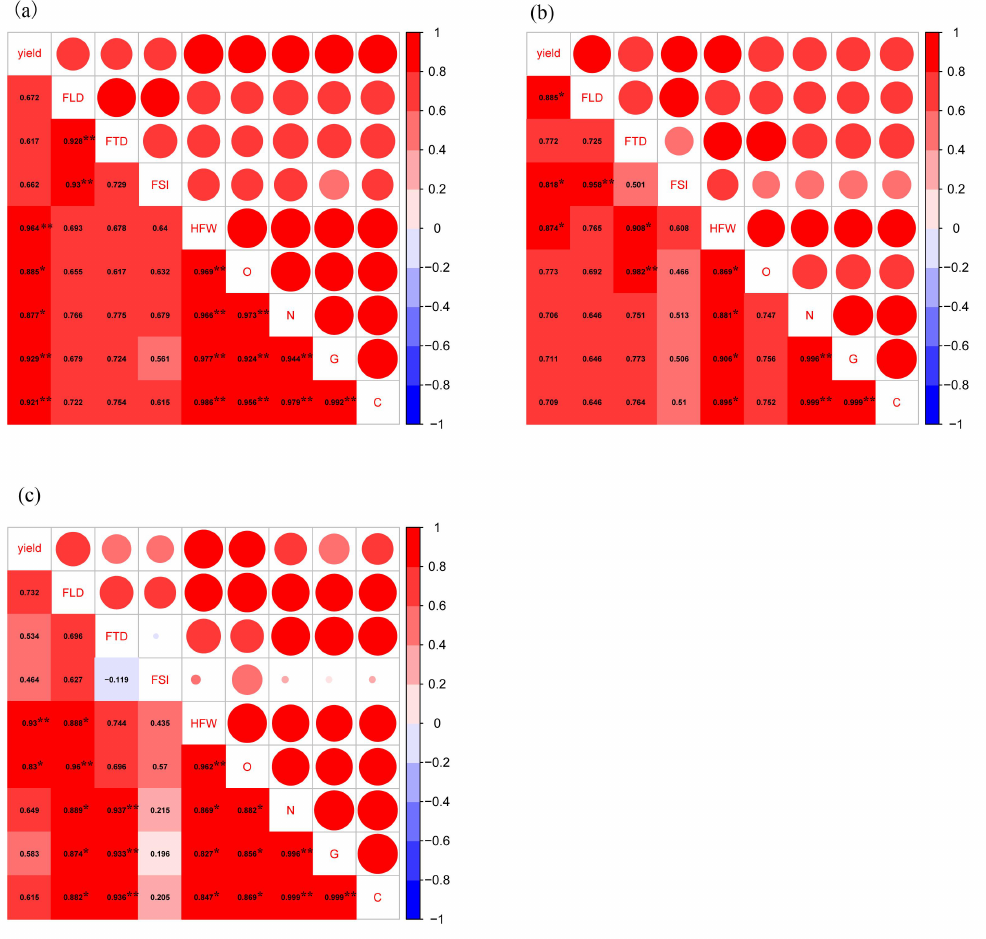
Figure 5. Analysis of the yields, yield components, oil contents, and citral contents under zinc sulfate ( a ), boric acid ( b ), and zinc sulfate + boric acid ( c ) foliar applications in L. cubeba . The cells of the lower left triangle and the circles of the upper right triangle mean the same. The color in red indicates a positive correlation and blue indicates a negative correlation. The darker the color, the larger the correlation value. The correlation factors are labeled on the middle diagonal. The abbreviations “O”, “N”, “G,” and “C” represent the oil content, neral, geranial, and citral, respectively. The symbol “*” indicates a significant correlation at the 0.05 level, and “**” indicates an extremely significant correlation at the 0.01